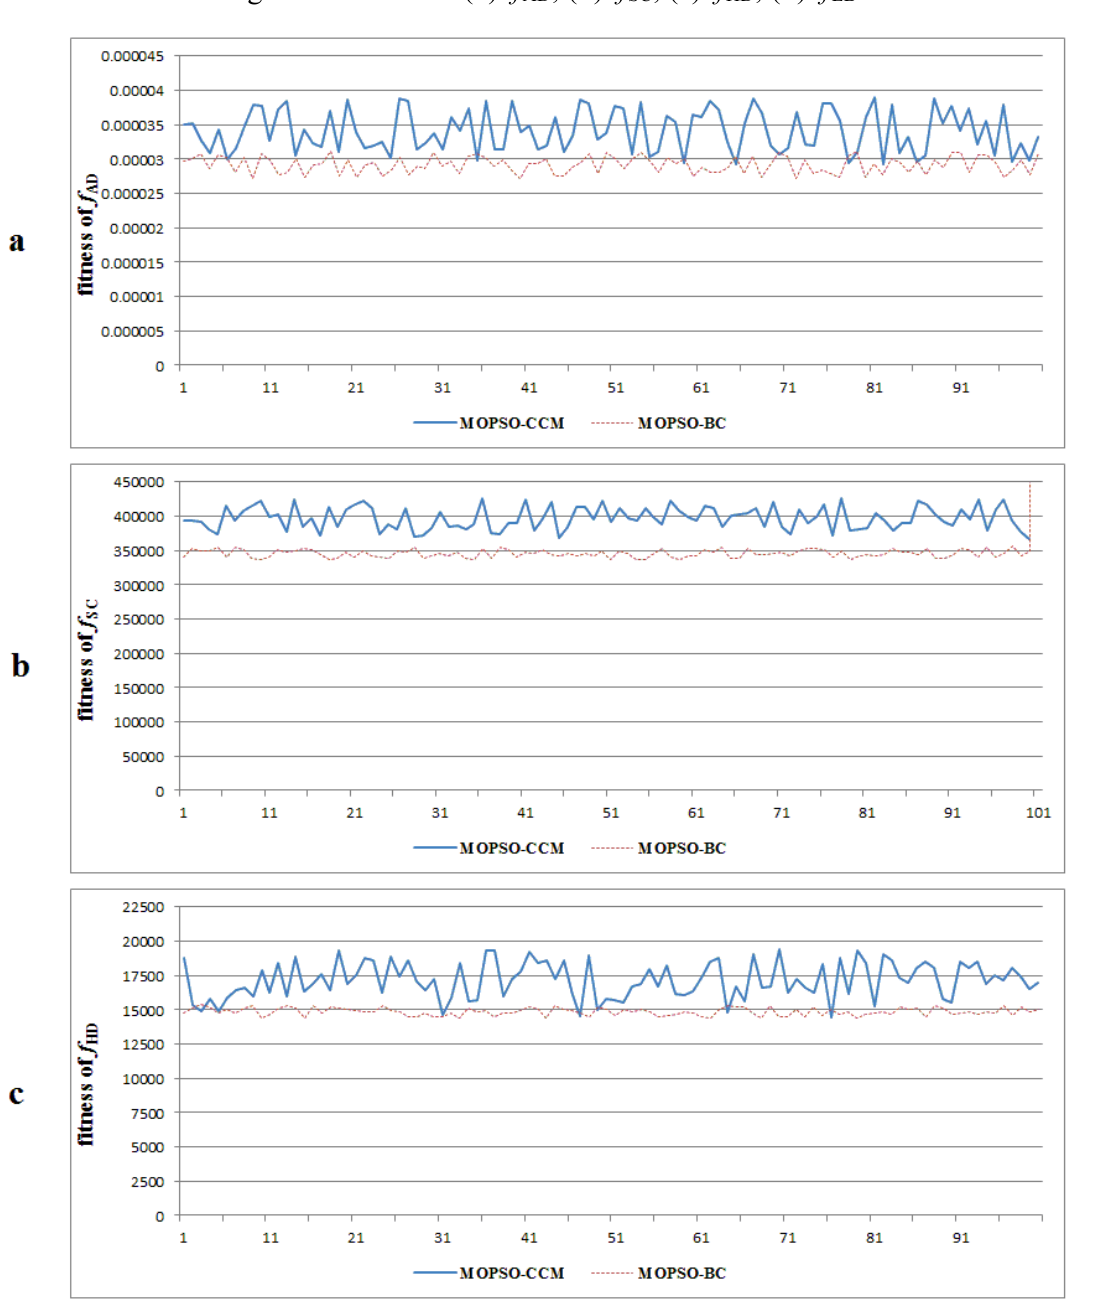
; ( b ): f ; ( c ): f ; ( d ): f AD SC HD EB